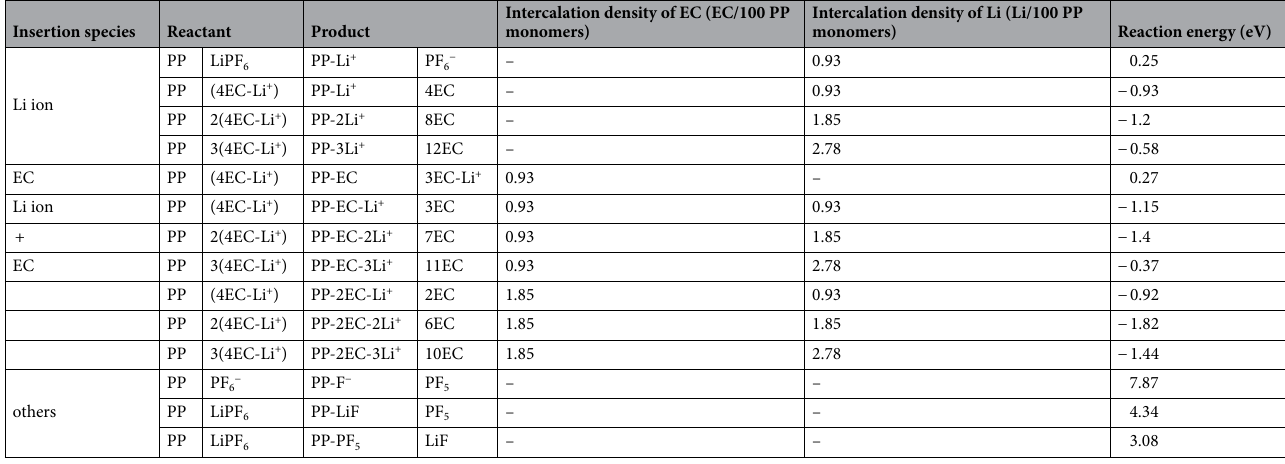
Table 5. Reaction energies of Li-ion insertion effects in